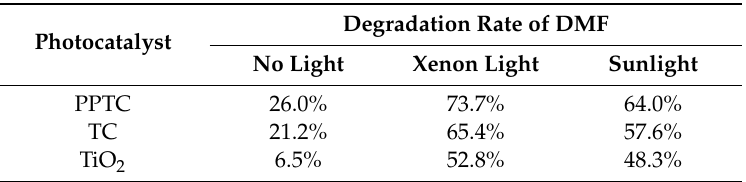
Table 2. Degradation rate of DMF catalyzed by photocatalysts without illumination and under irradiation of simulated sunlight (Xe lamp) or real sunlight.